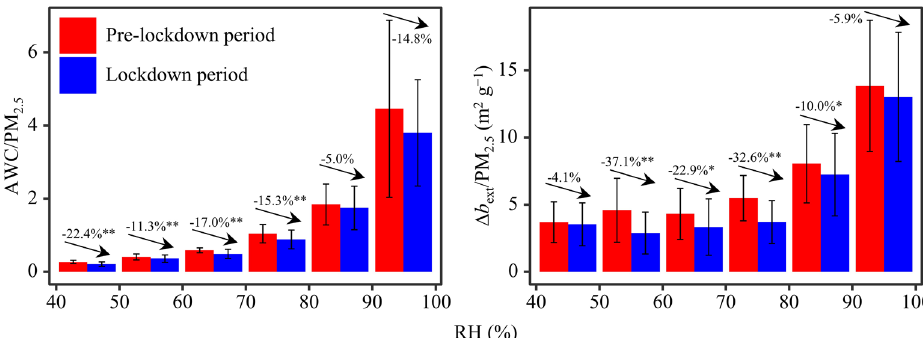
Fig. 4 Roles of aerosol composition variations on AWC and Δ b ext . Comparisons of the normalized aerosol water content (AWC/PM 2.5 ) and the differences ( Δ b ext ) between ambient and measured b ext ( Δ b ext /PM 2.5 ) for pre-lockdown period and lockdown period under various relative humidity (RH) ranges. * p < 0.05; ** p < 0.01. The error bar represents one standard deviation.